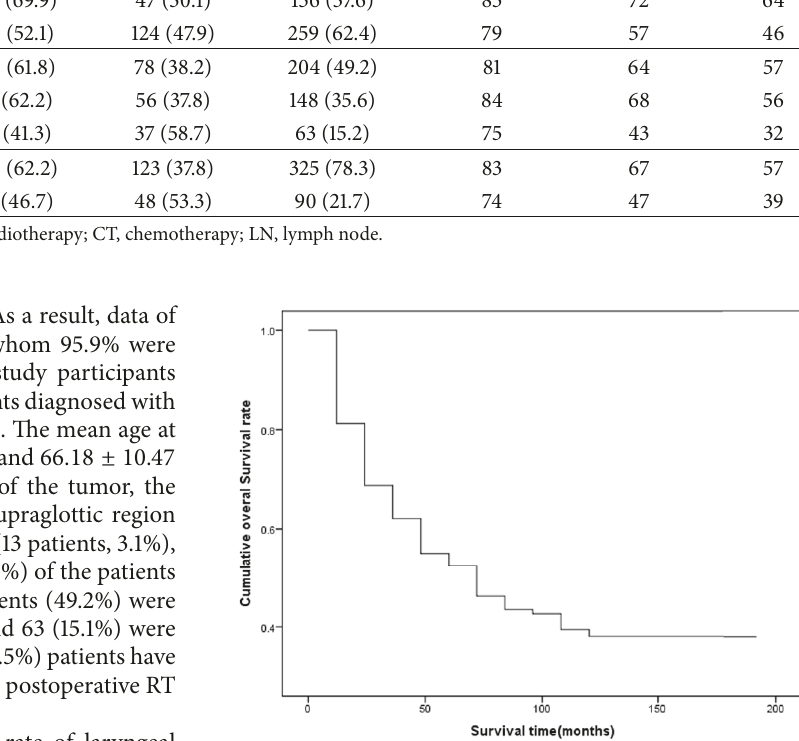
tumor stage, patients who did not have surgery, and patients with positive L. node had lower survival rates. There was no significant relationship between survival rate and gender, the location of the tumor, or type of histology ( 𝑃 > 0.05